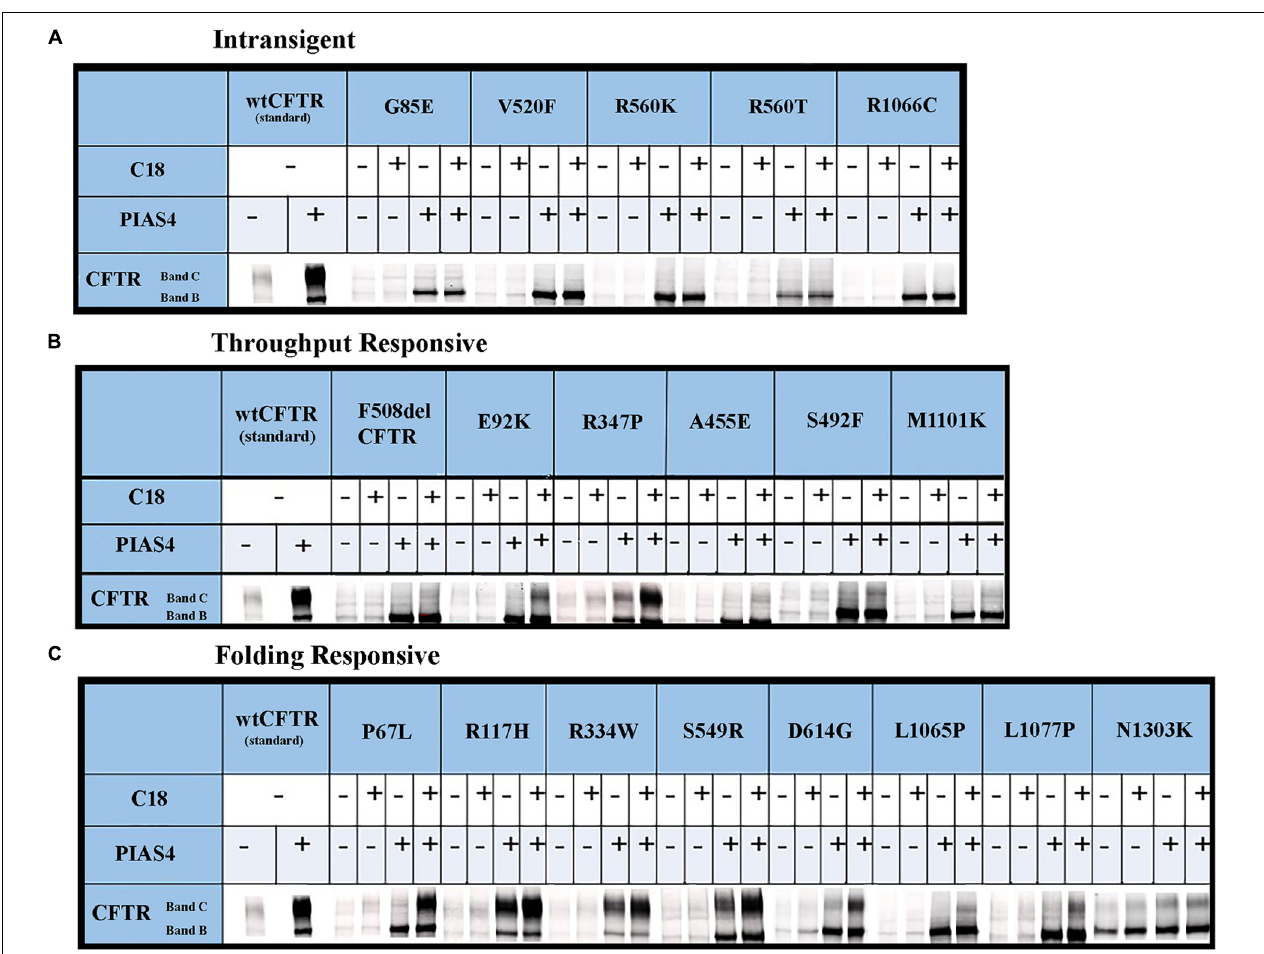
FIGURE 5 | Immunoblots illustrating CFTR folding variants: the raw data. CFTR folding mutations that produce different levels of band C under control conditions can be distinguished by their responses to corrector C18 as PIAS4 elicits CFTR band B overexpression. See the text in the “Results” section and Figure 4 legend for the identification of mutants and the definition of their categories. The corrector C18 was identified during medicinal chemistry that led to the discovery of corrector VX-809/Lumakaftor (Van Goor et al., 2011).